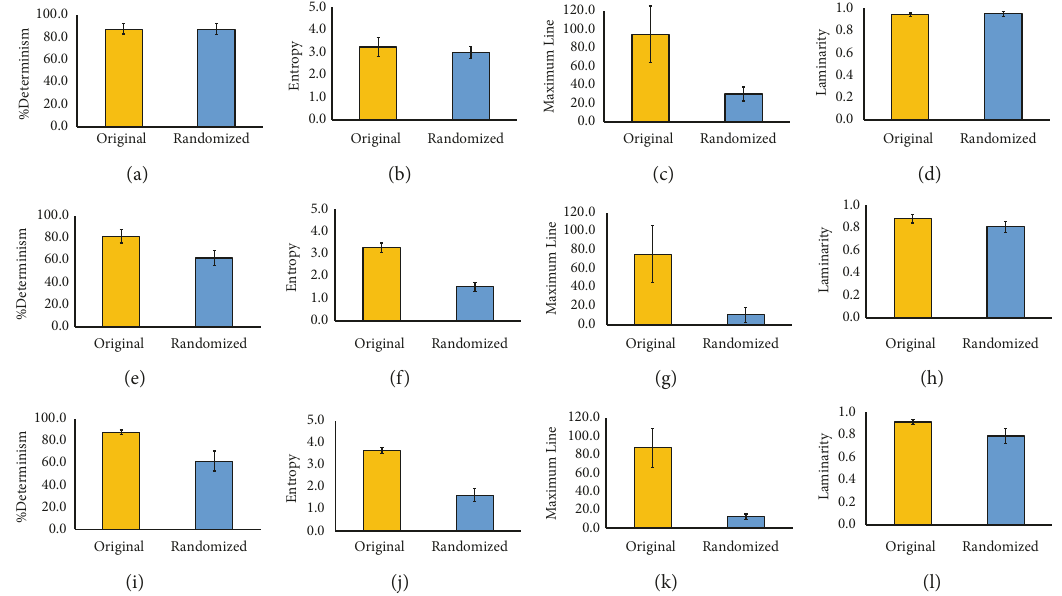
Figure 4: Mean and standard errors of determinism (Panels (a), (e), and (i)), entropy (Panels (b), (f), and (j)), maximum line (Panels (c), (g), and (k)), and laminarity (Panels (d), (h), and (l)) when segmenting by individuals (child, caregiver, and stranger).